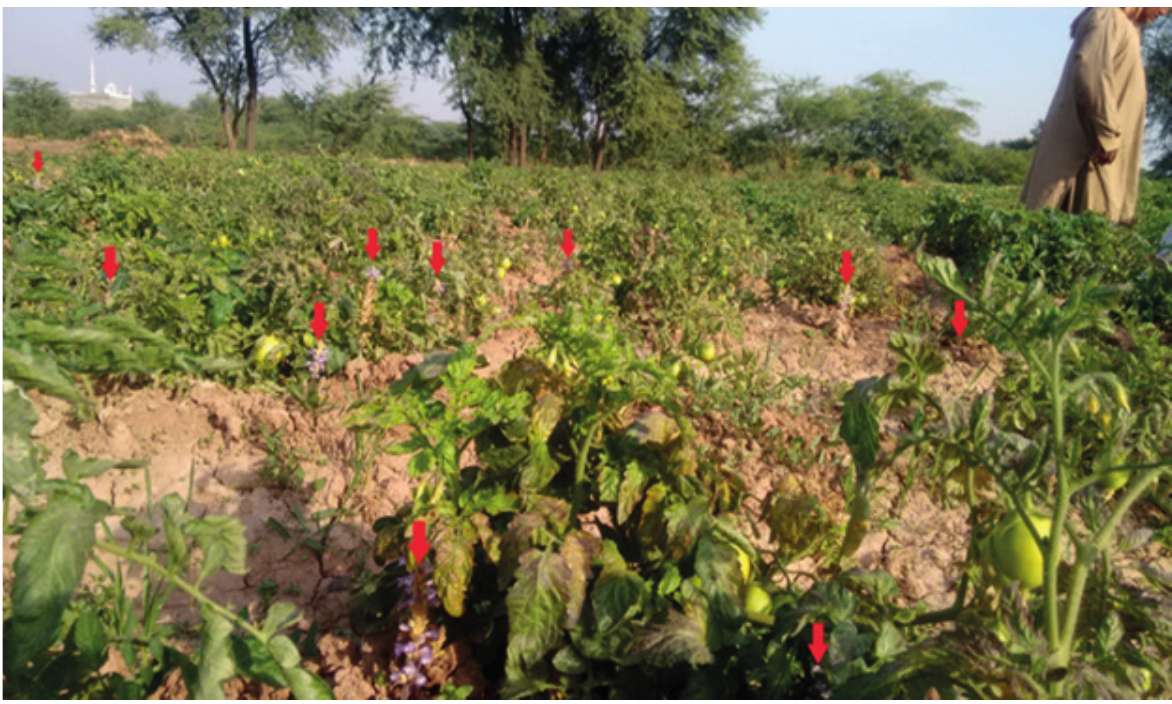
Figure 1 - Orobanche aegyptiaca in tomato fields in